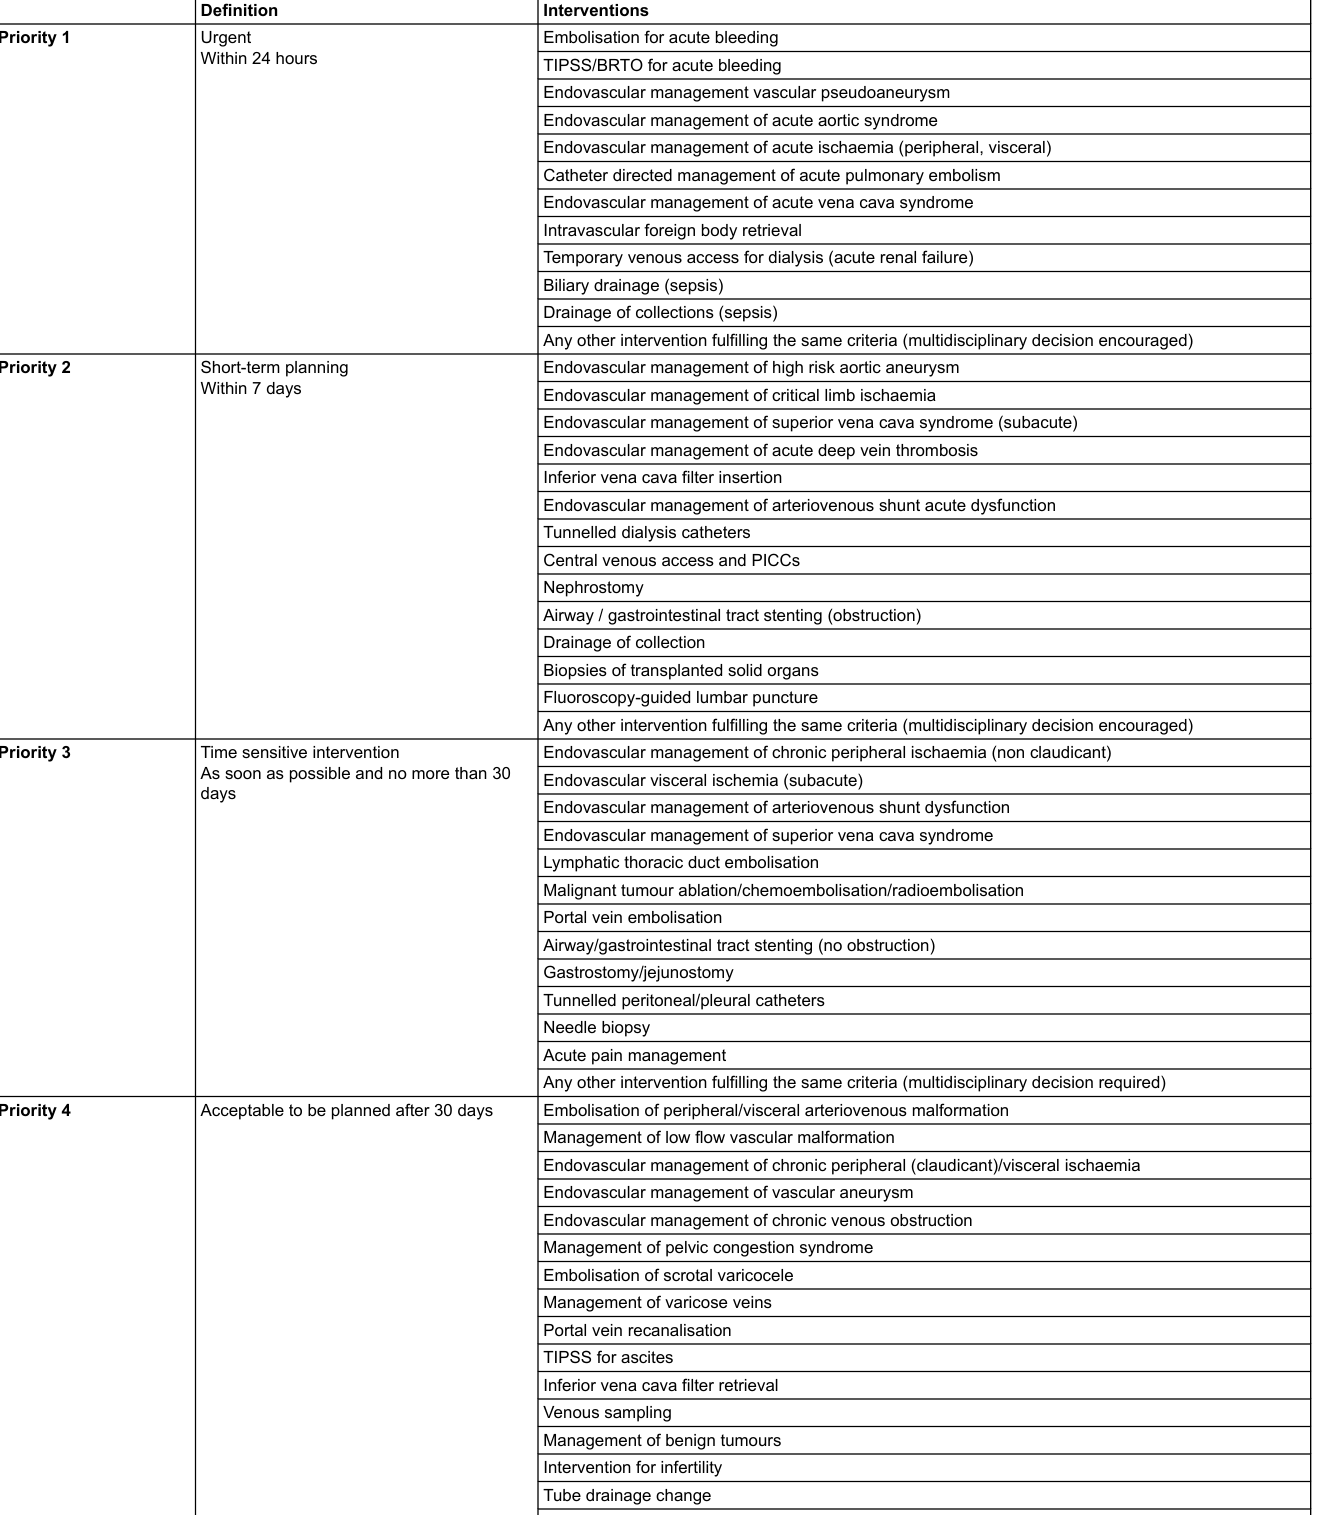
Table 2: IR intervention priority: proposal from the Swiss Society of Vascular and Interventional